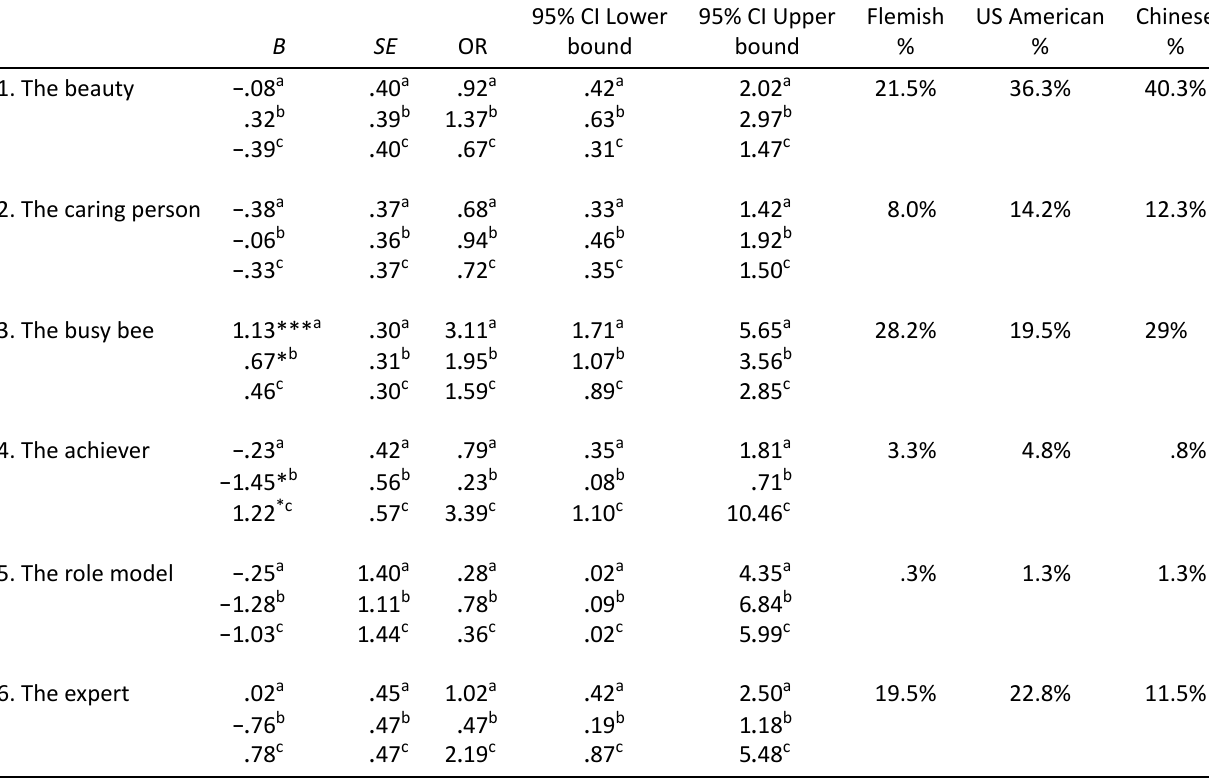
Table 3. Cultural differences in the use of